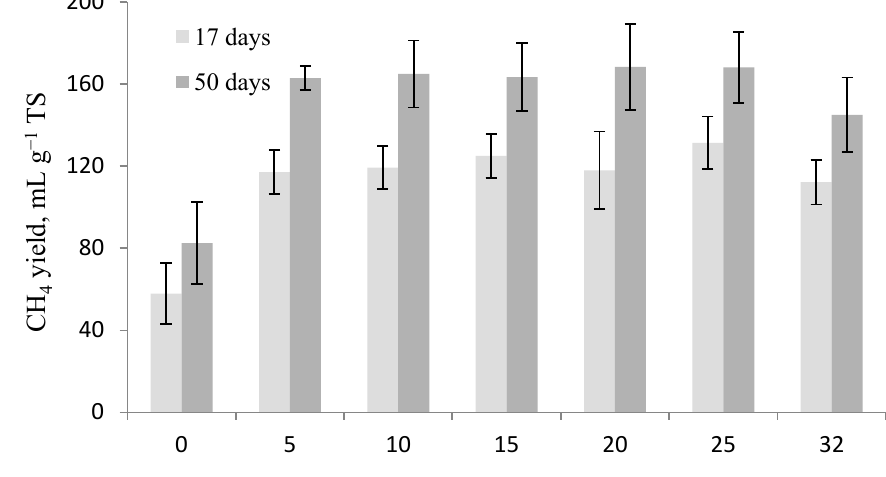
Figure 1. Methane yield after 17 and 50 days of anaerobic digestion of non-treated (0% in NH ) and AAS-treated for 3-d digested swine manure fibers with different reagent 3 concentrations in